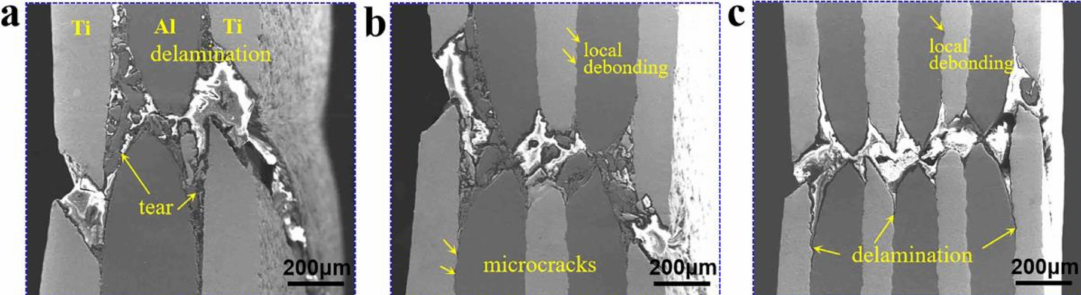
Figure 9. SEM images of the deep-drawing broken parts of Ti/Al multilayered composites with ( a ) three layers, ( b ) five layers, and ( c ) seven layers along the RD-ND surface at the